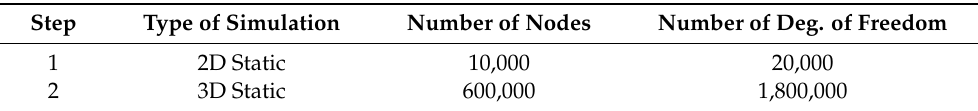
Table 10. Number of nodes and number of degrees of freedom from the 2D FE model (Section 3.1.1) and the 3D FE model (Section